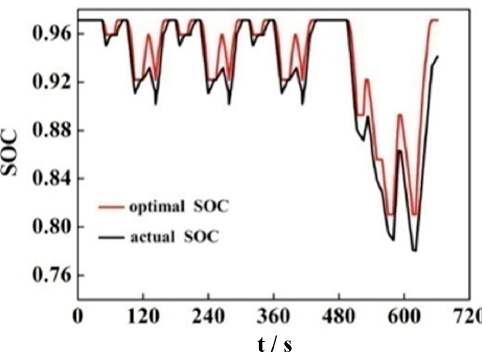
Figure 13. Charge and discharge current distribution of supercapacitors and batteries under SOC control strategy.